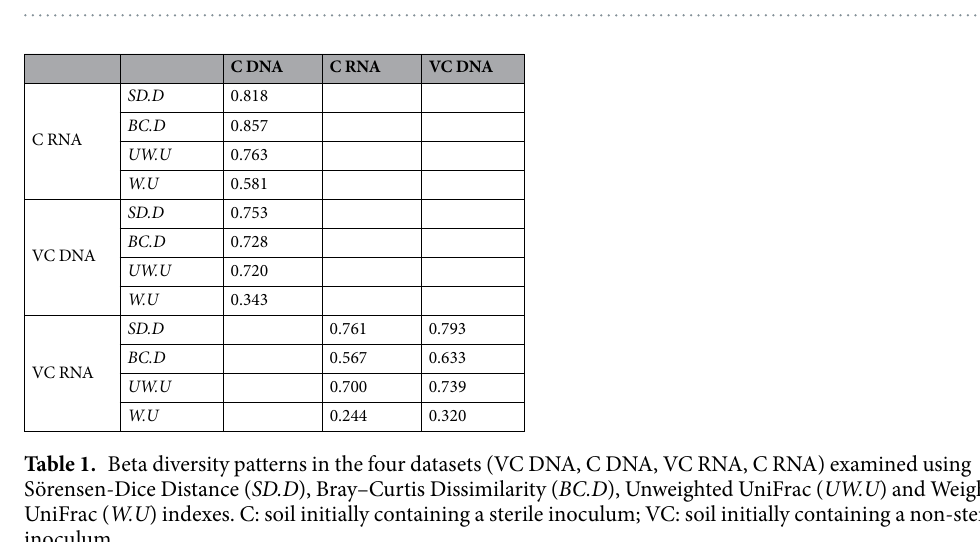
Figure 4. Relative abundance of total (16S rRNA gene) and active (16S rRNA transcript) bacteria in potting soil initially containing a sterile (Control)/non sterile (Vermicompost) inoculum.